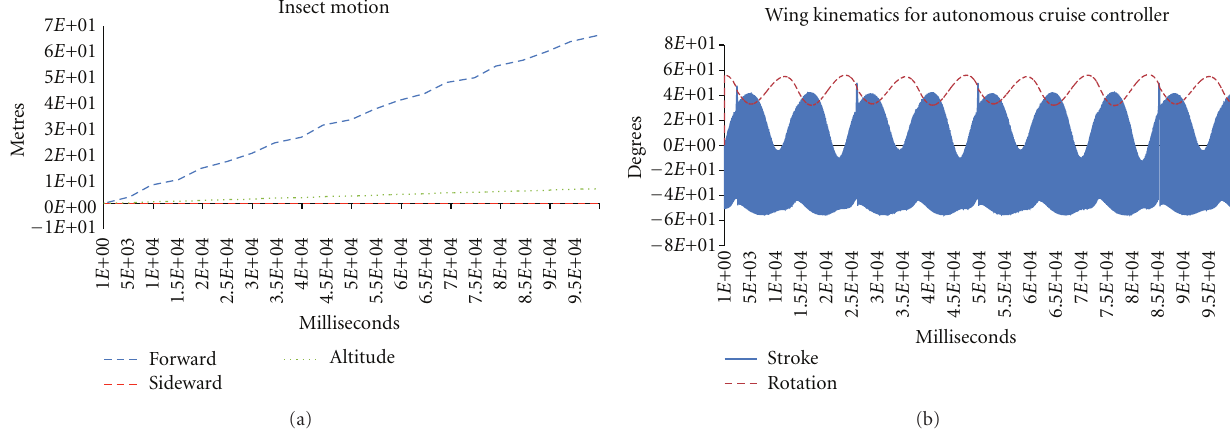
Figure 6: The motion of the MFWR in three dimensions (shown in (a)) controlled by a Cruise Mode Controller actuated wing kinematics (shown in (b)). Here the stroke kinematics has relatively higher beats rate than that of the rotation for the above controller shown in the figure, thus the oscillation cycles are cluttered, making it hard to visualize them with respect to the rotation